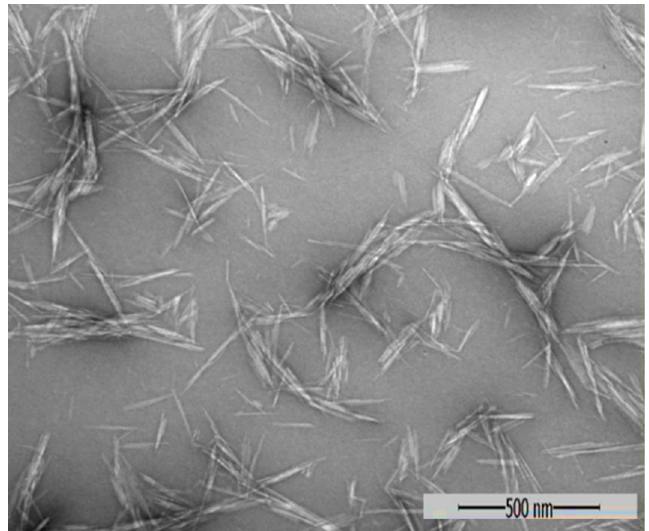
Figure 3. Morphological characteristics of nanochitin whisker visualized by TEM. A nanochitin sample with a concentration of 0.0024% w/v was prepared by diluting a stock of nanochitin suspension with DI water. Some of the nanoparticles were aggregated during the drying process of the sample in preparation for TEM.